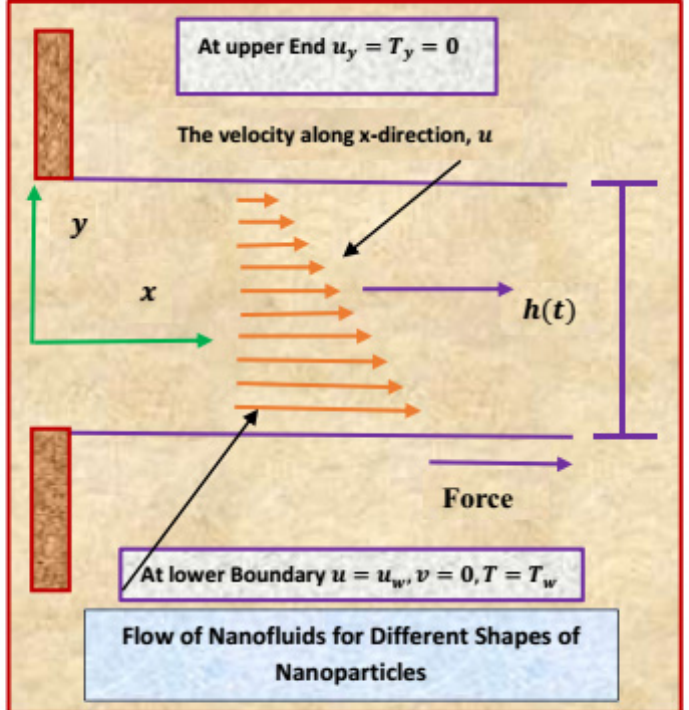
Figure 1. The flow of nanofluid composed of multiple nanomaterials.